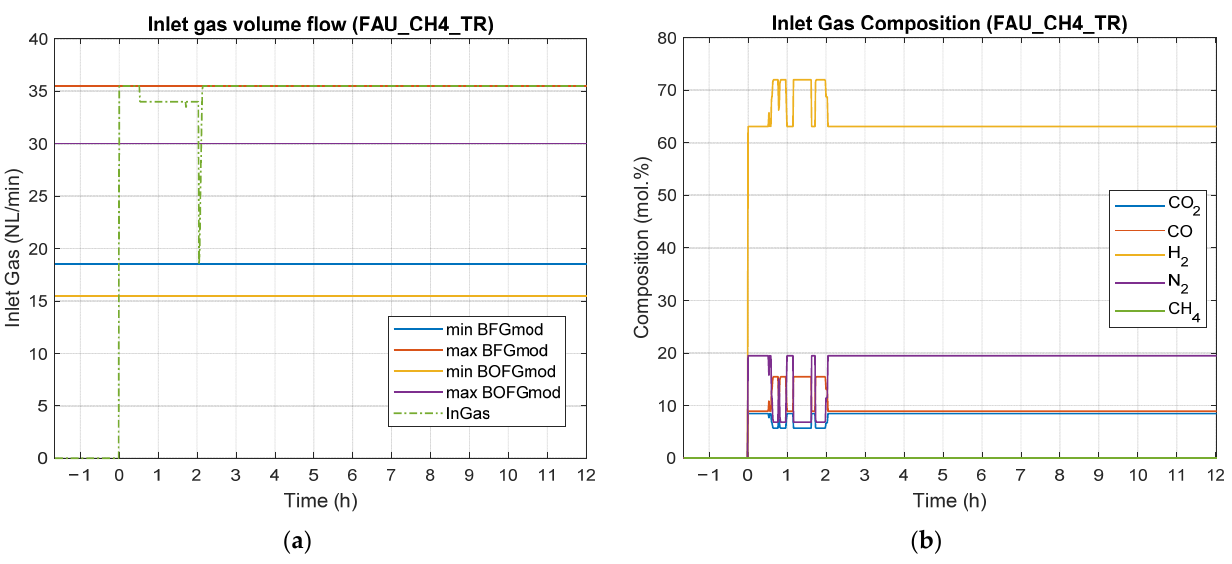
Figure 12. SC2. Control strategy for FAU_CH4_TR. ( a ) Inlet gas volume flow; ( b ) inlet gas composition.